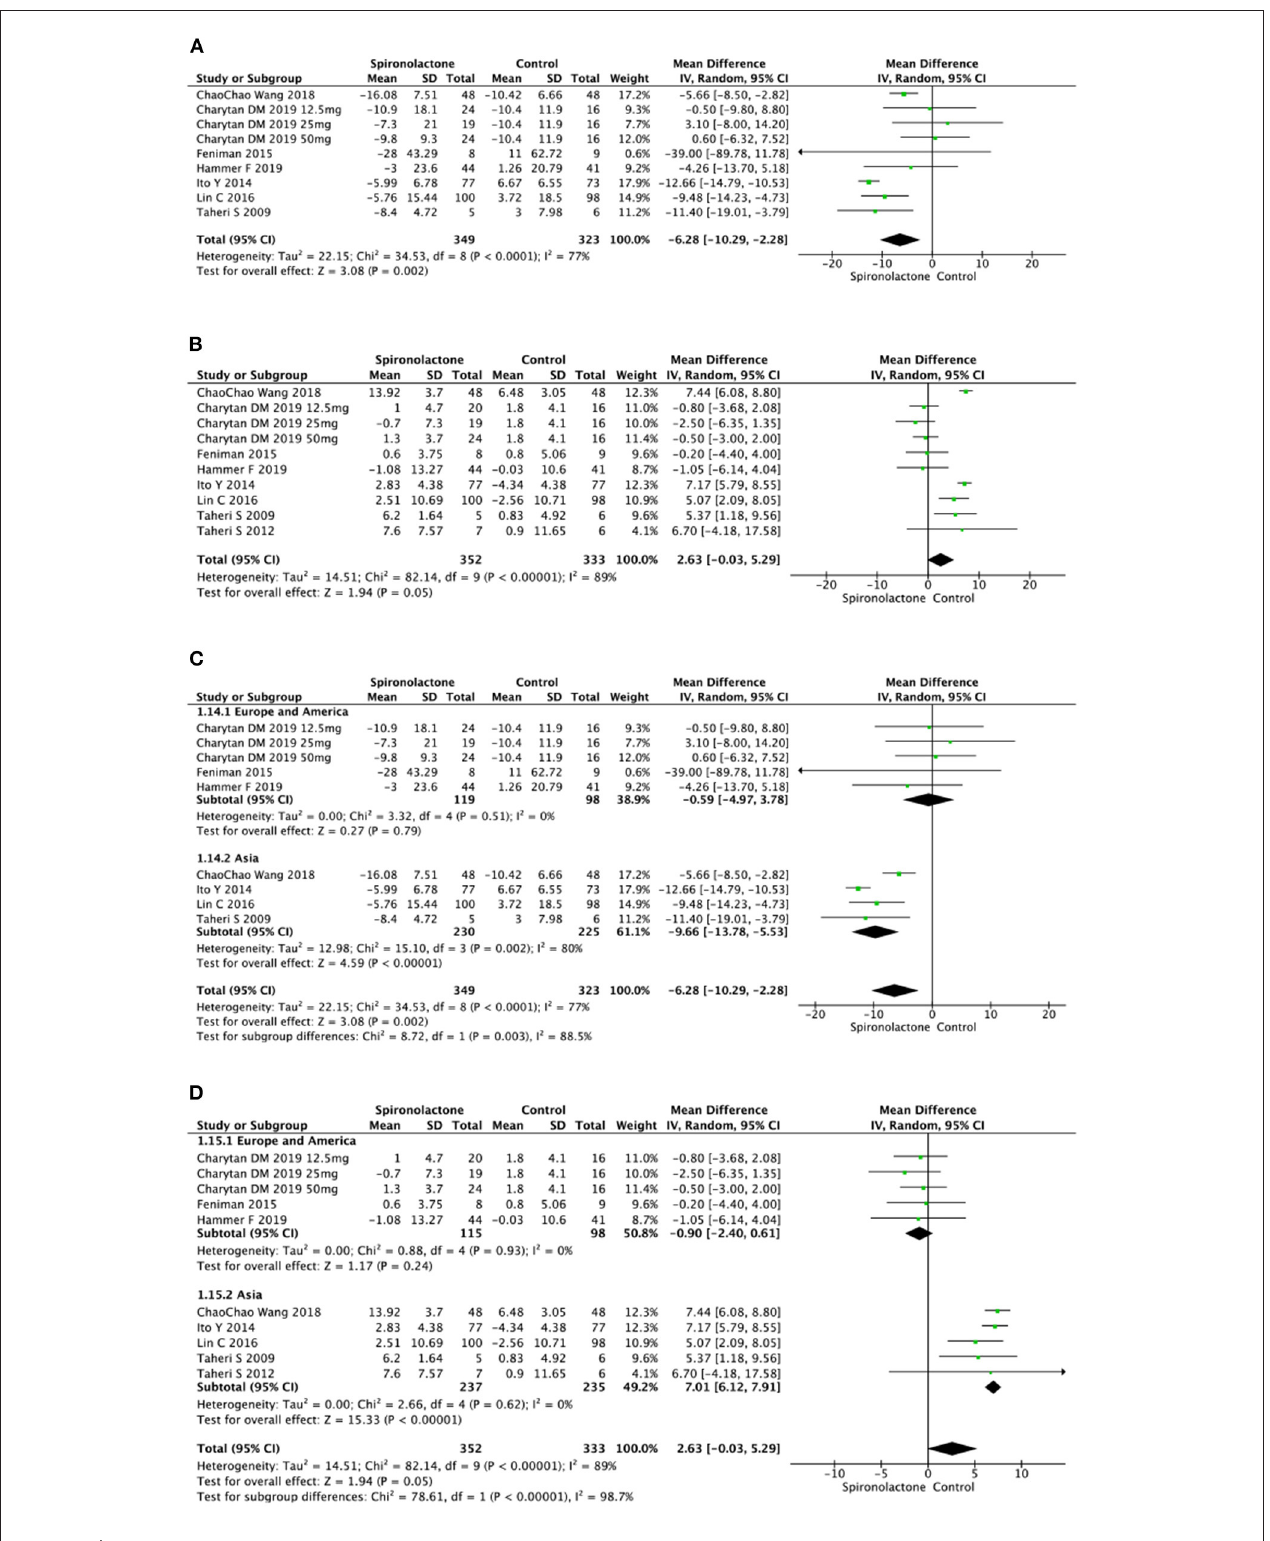
FIGURE 7 | (A) Effect of spironolactone on LVMI; (B) Effect of spironolactone on LVEF; (C) Effect of spironolactone on LVMI after subgroup analysis; (D) Effect of spironolactone on LVEF after subgroup analysis. LVEF, left ventricular ejection fraction; LVMI, left ventricular mass index.